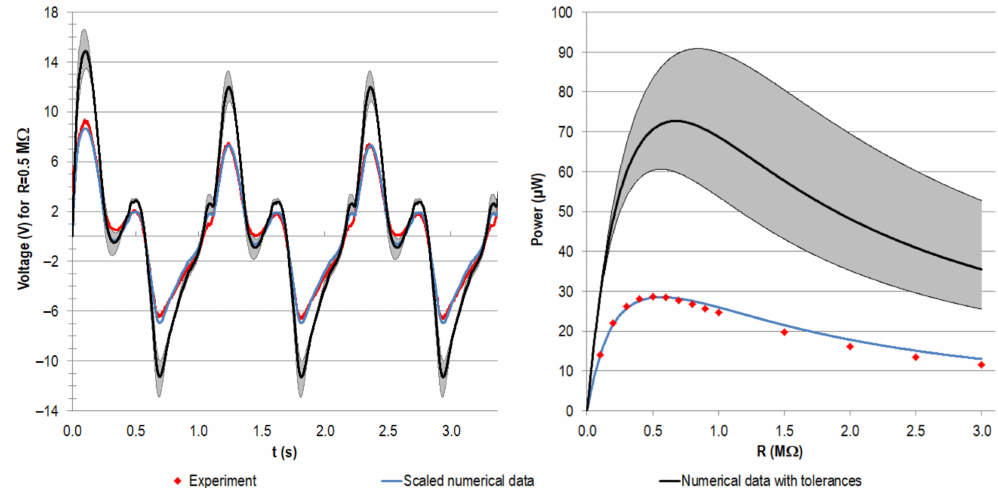
Figure A3. Exemplary voltage curves (V) for the first three cycles at R = 0.5 M Ω ( left ) and generated power output ( µ W) for variable load resistances ( right ). The initial numerical data (black) were scaled (blue) with the data from the regression model based on sinusoidal input. For the Bergman load profile, the scaled voltage matches the experimental data (red) notably better, resulting in high accordance with the power